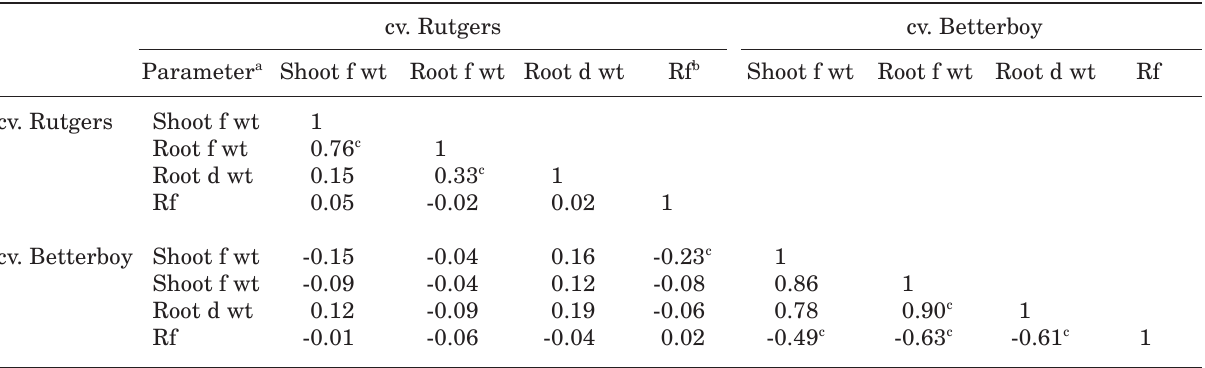
Table 2. Coefficients of correlation among the parameters of the virulence test in a susceptible (Rutgers) and a resistant (Betterboy) tomato